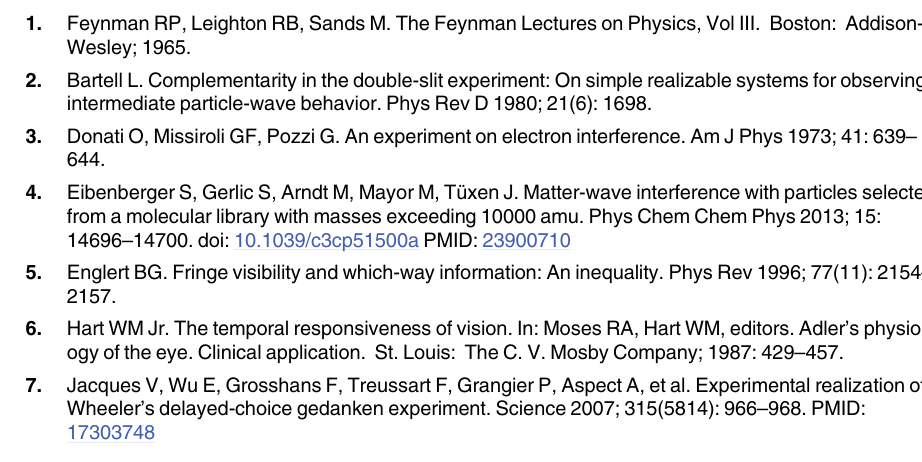
S1 Fig. Classic slow-phase adaptation curves. After approximately 20-min exposure to dark conditions, the rods achieve maximum sensitivity. S2 Fig. Maximum sensitivity for scotopic vision (from [33], p. 168). Overlay of measured data (solid line with experimental values) with theoretical prediction (dotted